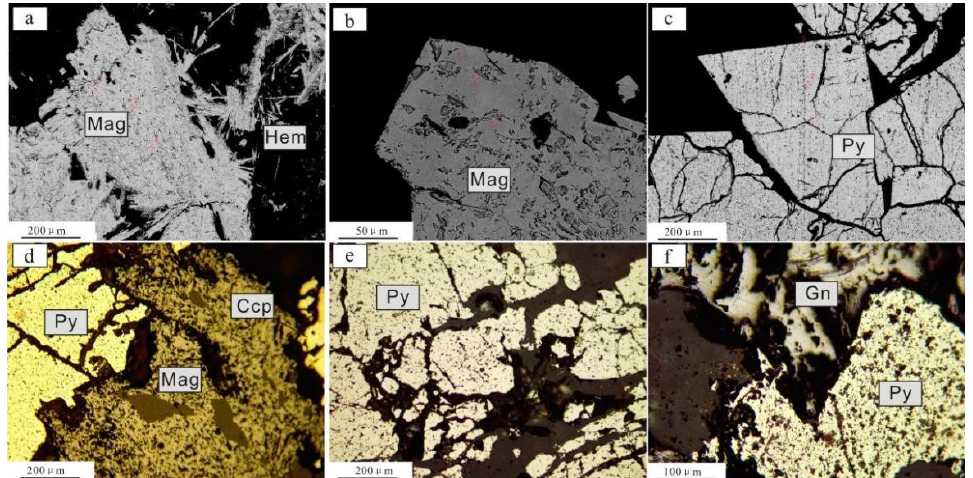
Figure 6. Photomicrographs showing textures and occurrences of magnetite/pyrite in the Dongping gold deposit: ( a ) BSE image of magnetite and hematite; ( b ) BSE image of euhedral magnetite; ( c ) BSE image of euhedral pyrite; ( d ) Reflected light image of magnetite-pyrite-chalcopyrite; ( e ) Reflected light image of pyrite aggregate; ( f ) Reflected light image of pyrite and galena. Ccp—chalcopyrite; Gn—galena; Py—pyrite; Mgt—magnetite;